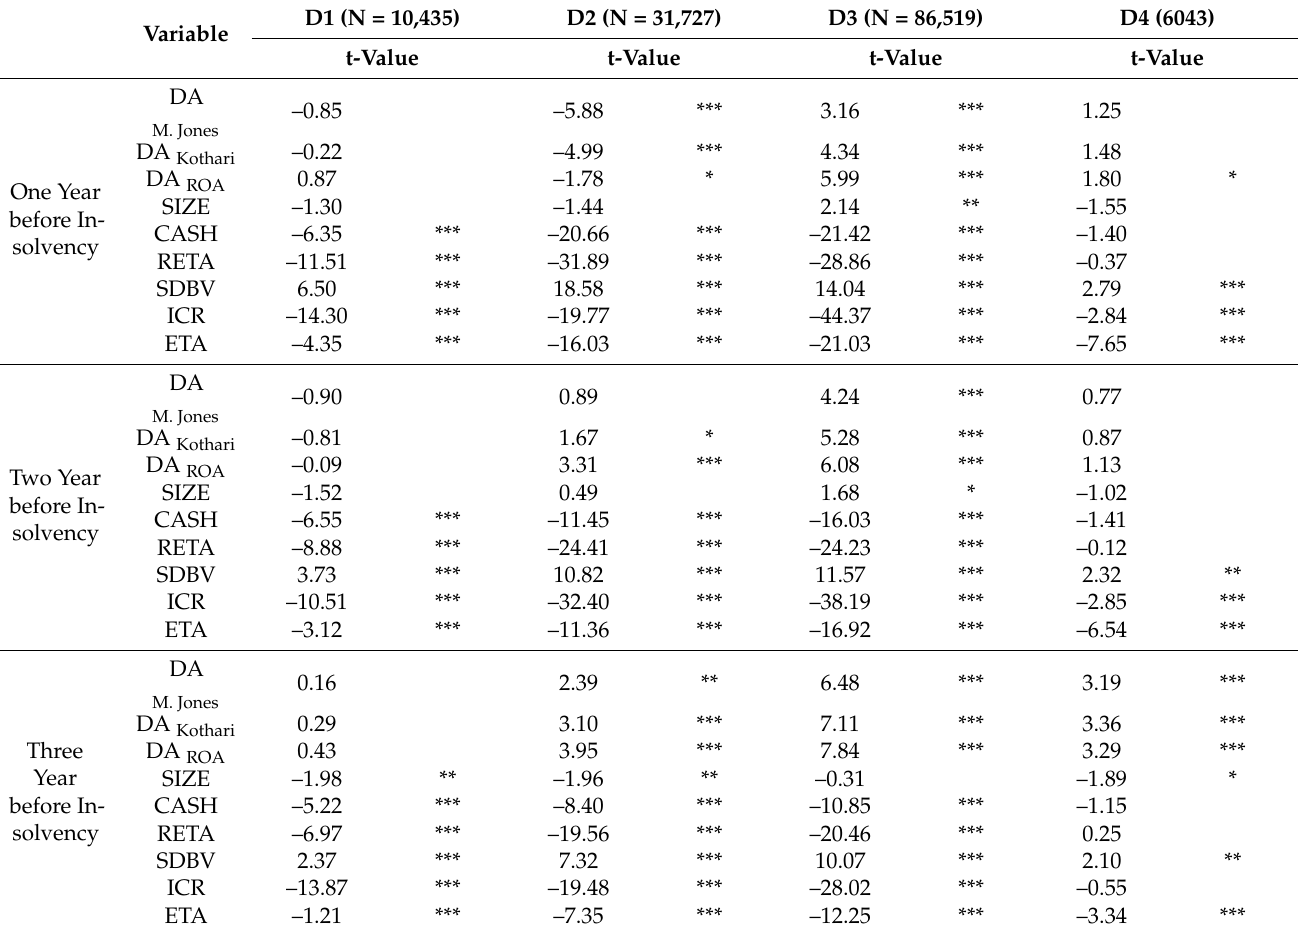
Table 6. T-test between insolvent and non-insolvent